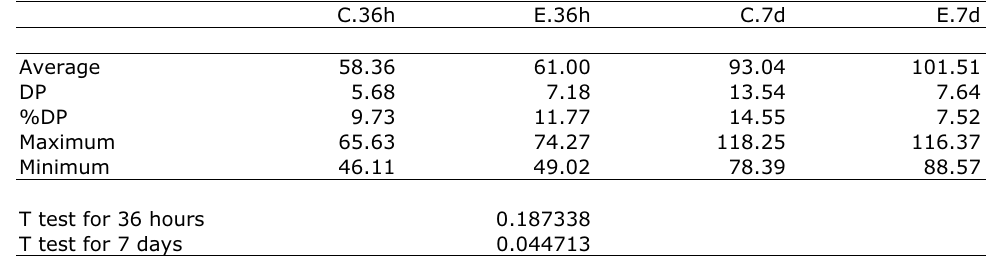
TABLE 1 – Percentage of liver mass gain at the two times studied in the control and experiment